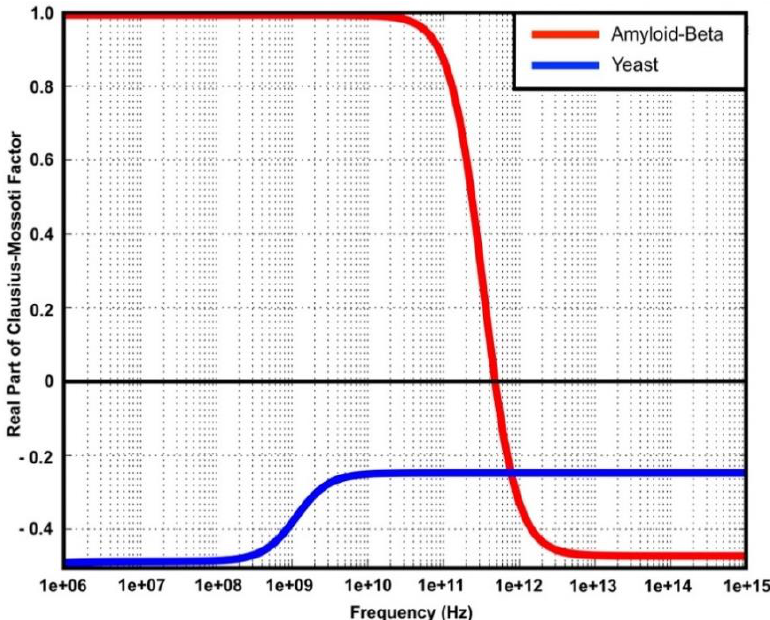
Table 2. Parameters for the Clausius – Mossoti Factor Calculation.